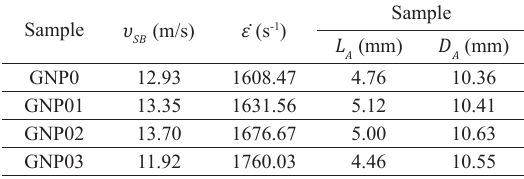
Table 1. Split Hopkinson pressure bar parameters: impact velocity